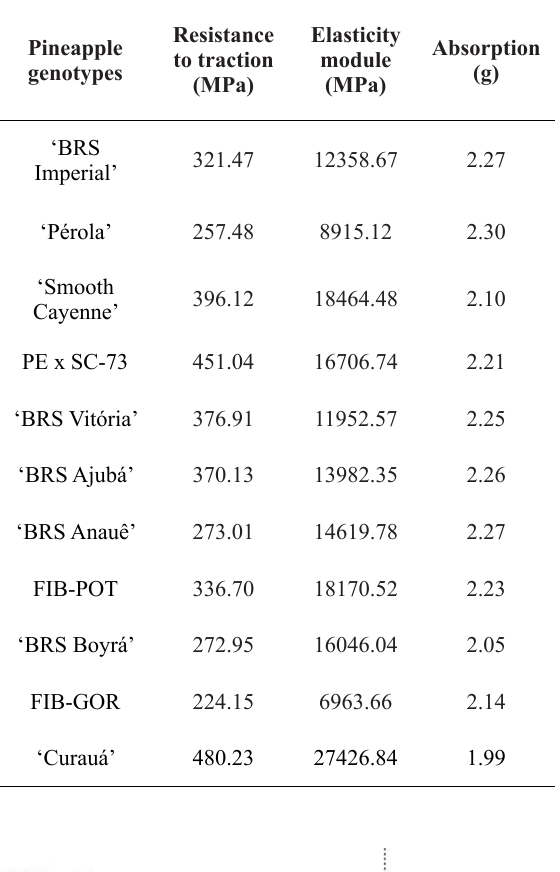
Values for resistance to traction, modulus of elasticity, and absorption of water indices for the leaf fibers of the pineapples studied.